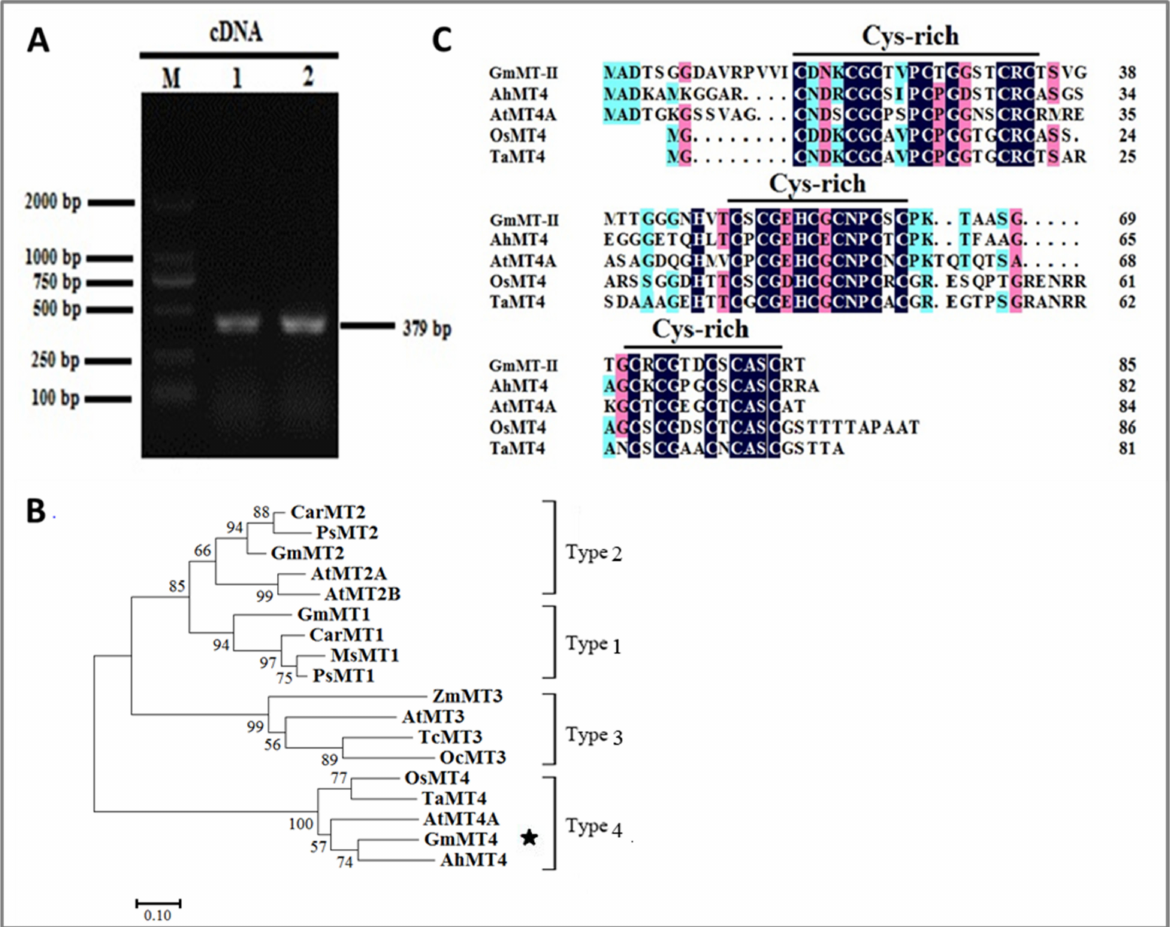
Figure 1. Isolation and identification of GmMT-II from Xiangdou No. 3 and Ningzhen No. 1 soybean cultivars ( A ). Isolation of cDNA of GmMT-II gene from soybean cultivars; ( B ) Phylogenetic tree analysis was performed by the MEGA 6 program with the neighbor joining method and with 1000 replicates. The phylogenetic tree was constructed based on the aligned amino acid sequence of 18 homologous metallothioneins (MTs) proteins. The asterisks indicate GmMT-II. ( C ) Alignment of amino acid sequences of GmMT-II in soybean cultivars with MT-II-like proteins from different plants (Ah— Arachis hypogaea ; At— Arabidopsis thaliana ; Os— Oryza sativa ; and Ta— Triticum aestivum ). Furthermore, we aligned the amino acid sequence encoded by the GmMT-II gene with Type 4 MT proteins of other species, including Ah: Arachis hypogaea , At: Arabidopsis thaliana , Os: Oryza sativa , Ta: Triticum aestivum , and the results are shown in Figure 1B. The